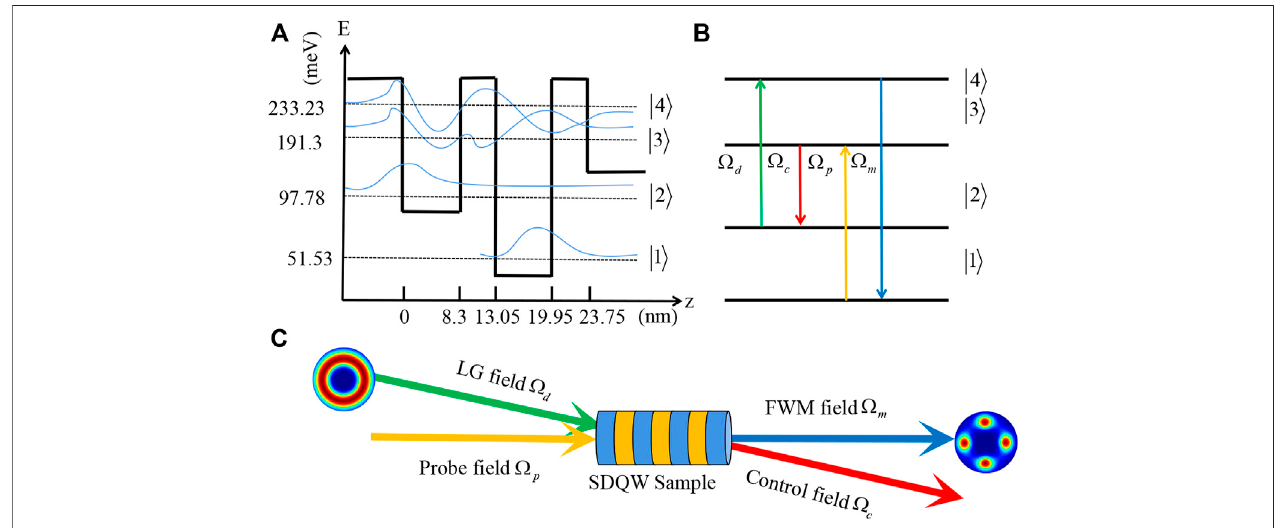
FIGURE 1 | (A) Schematic energy-band diagram of a single period of the asymmetric SDQW. (B) The corresponding energy-level arrangement. (C) Geometry of the four applied fi elds. In the FWM process, control fi eld Ω c , vortex driving fi eld Ω d , and probe fi eld Ω p interact with the SDQW and generate FWM fi eld Ω m under the phase-matching condition (cid:2) k p + (cid:2) k d (cid:2) (cid:2) k m + (cid:2) k c